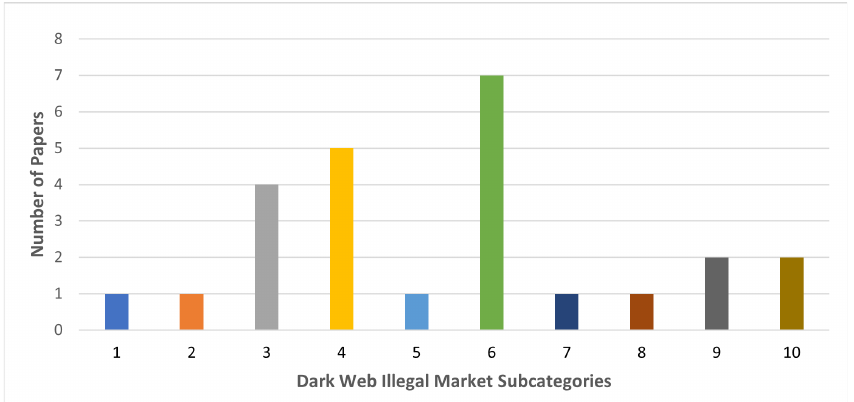
Figure 8. A snapshot of different Dark Web illegal market themes discussed by prior researchers with the distribution of papers for each subcategory.